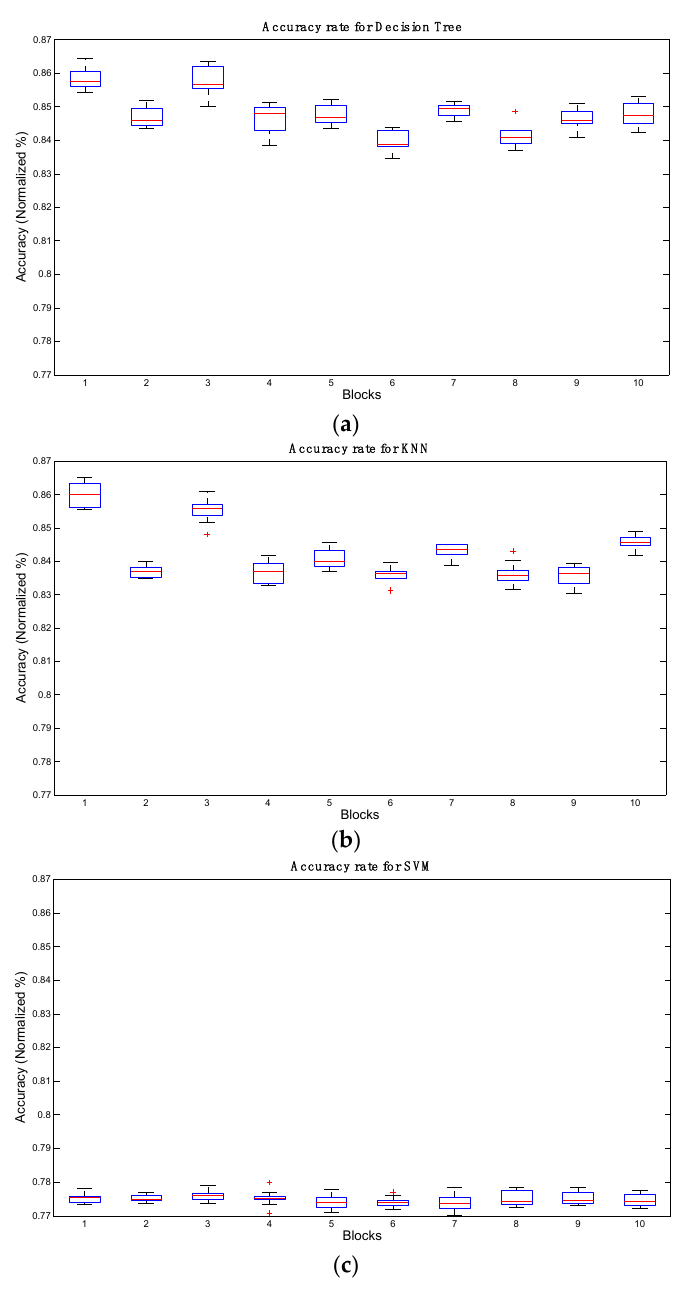
Figure 7. Graphical representation of accuracy rates for: ( a ) DT; ( b ) KNN and ( c ) SVM for different blocks. Therefore, the best accuracy results were obtained by block 1 with a movement dt = 4. Table 8 and Figure 8 show the behavior of data obtained for each participant in block 1. Table 8. Accuracy rate for 10 subjects using classifiers DT, KNN and SVM (block 1 and dt = 4). Classifier